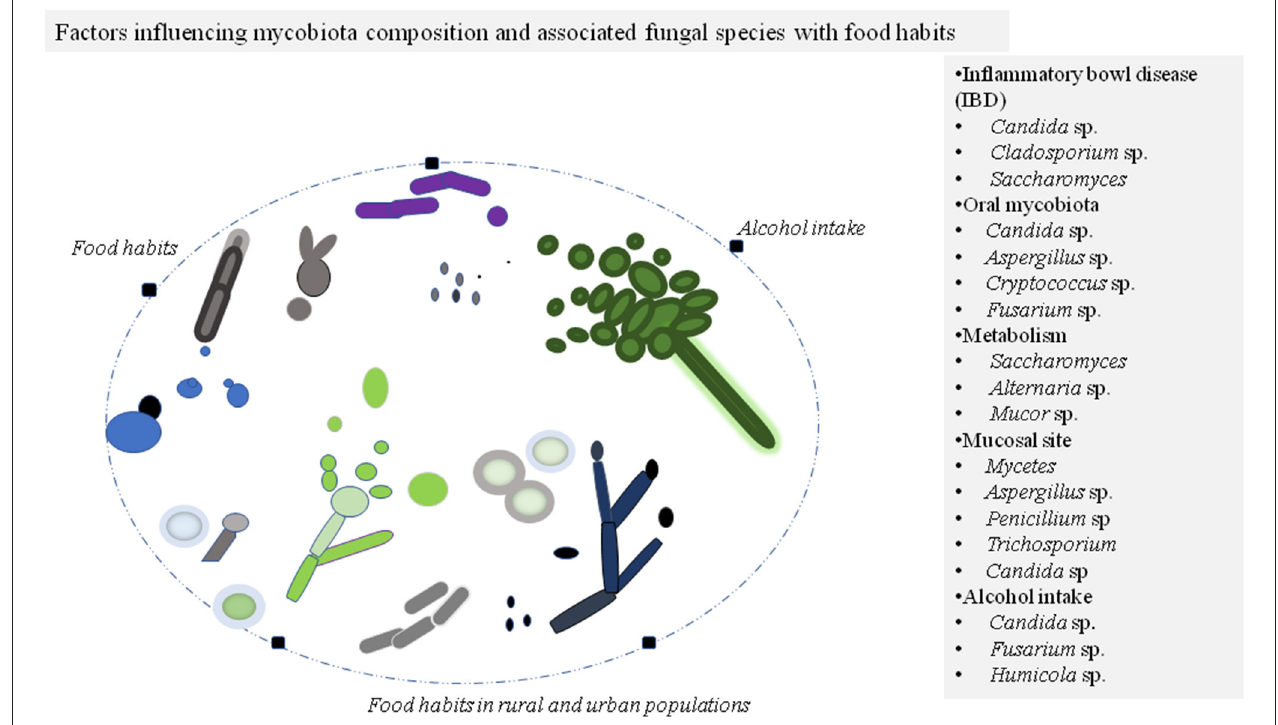
FIGURE 1 | Factors affecting mycobiota composition of the individuals commonly belong to phylum Ascomycota and Basidiomycota. The different morphotypes of fungal species are illustrated in colors for presentation purposes. The modulated fungal species during the disease state and other conditions are listed in the